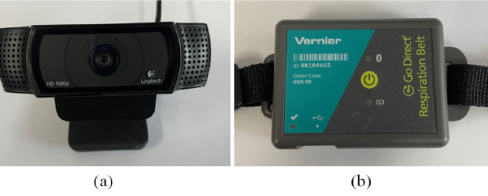
Figure 8. Data acquisition equipment for remote respiration measurement: ( a ) Logitech C920 pro, ( b ) Go Direct Respiration Belt. ( b ) Go Direct Respiration